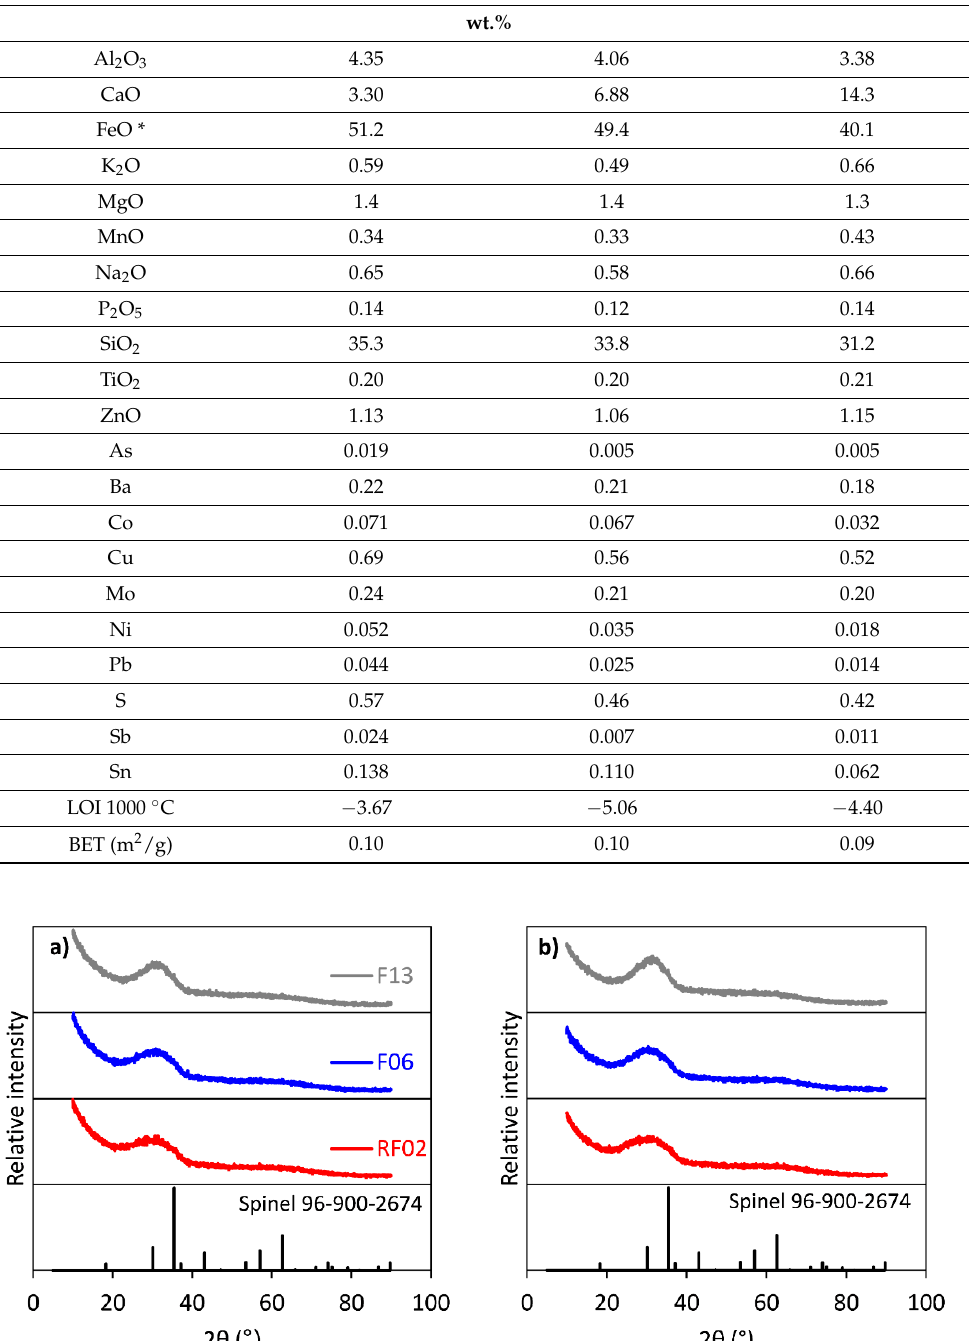
Table 1. Chemical compositions (wt.%) of main oxides and elements of 0.3–0.6 mm samples ana- lyzed by ICP–MS and sample data. * Total Fe calculated as Fe 2+ .